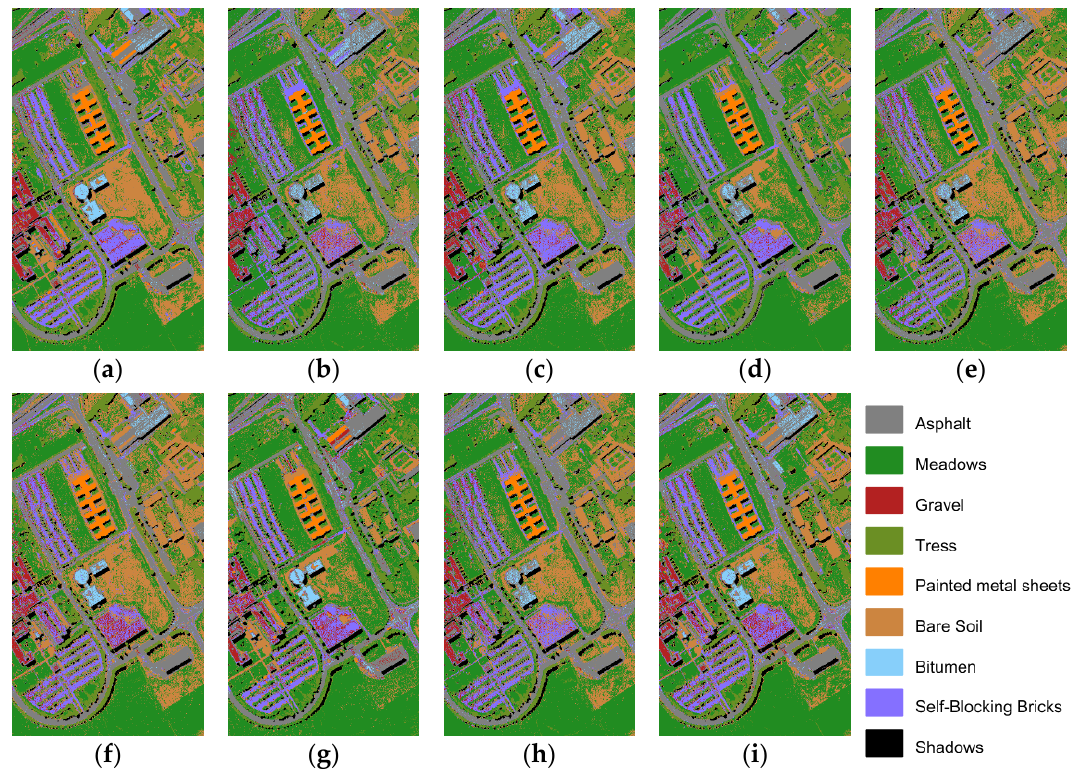
Figure 4. Classification maps of land types for different combination algorithms of Pavia University data. ( a ) PCA+SVM; ( b ) LDA+SVM; ( c ) LPP+SVM; ( d ) PCA+RF; ( e ) LDA+RF; ( f ) LPP+RF; ( g ) PCA+KNN; ( h ) LDA+KNN; ( i ) LPP+KNN. Table 4. Computational time of different methods (s). SVM Dataset Yellow River Estuary 0.08